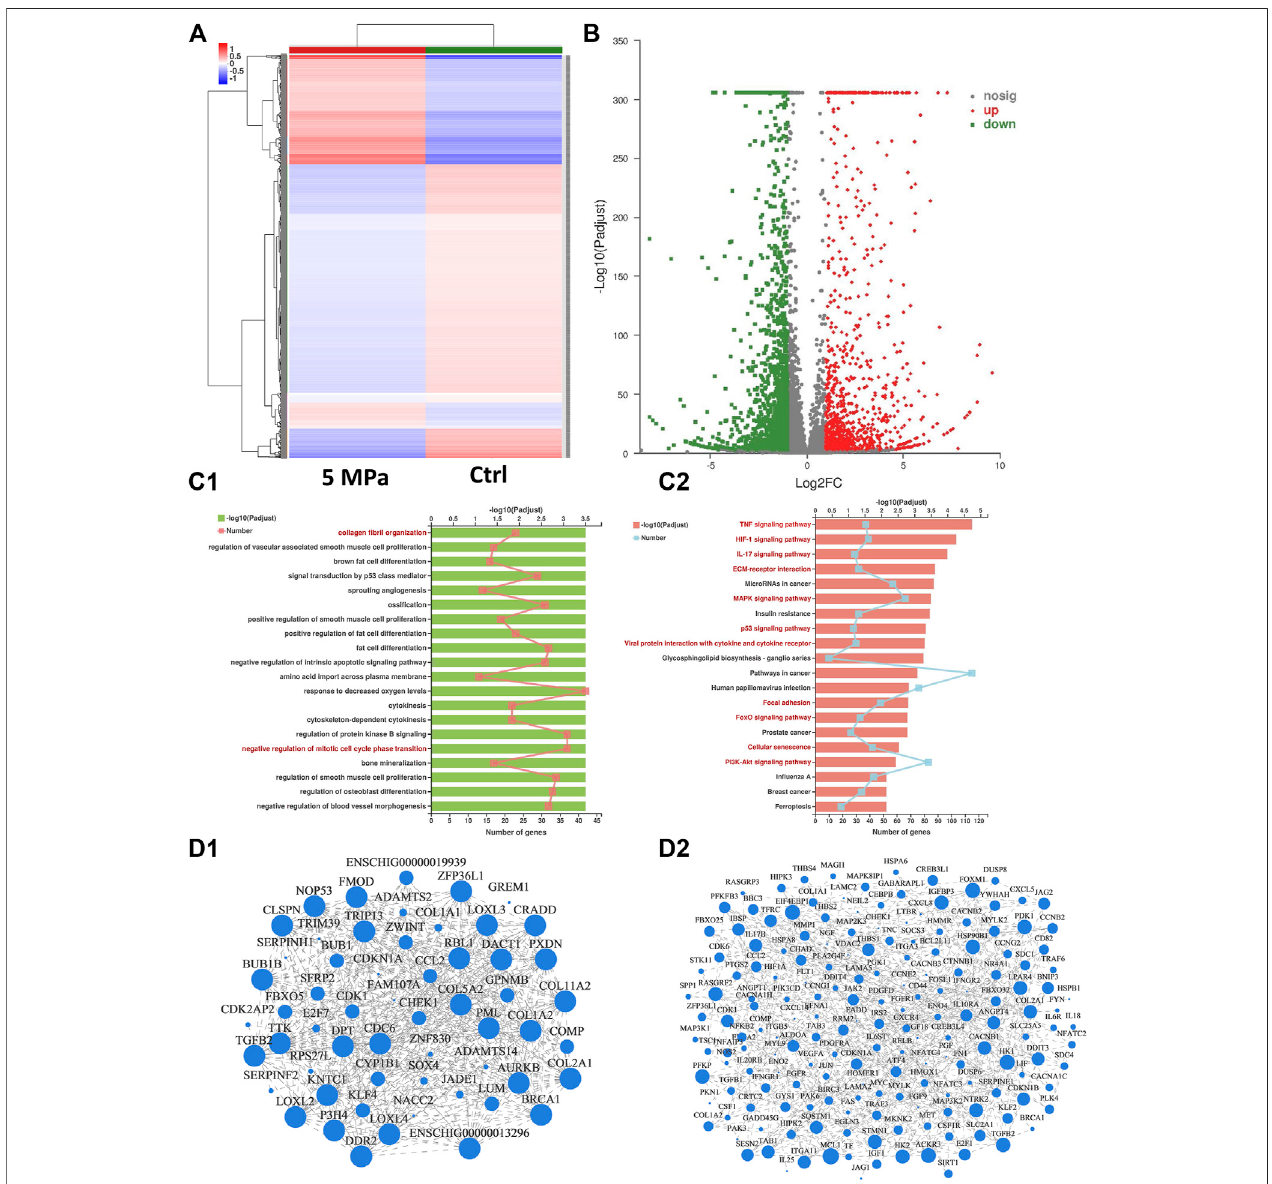
FIGURE 6 | Mechanism analysis of HP regulating in vitro cartilage regeneration at 4 weeks (A) Cluster analysis heat map exhibited differences in gene expression between the HP group and the control group. The stronger the red or blue, the greater the difference in expression. (B) Volcano map of signi fi cance in expression levels between the HP group and the control group. A large number of genes were differentially expressed due to the effect of HP. (C) Functional enrichment analysis categorized differentially expressed genes into pathways referring to GO (C1) and KEGG (C2) databases. 20 potential signaling pathways with